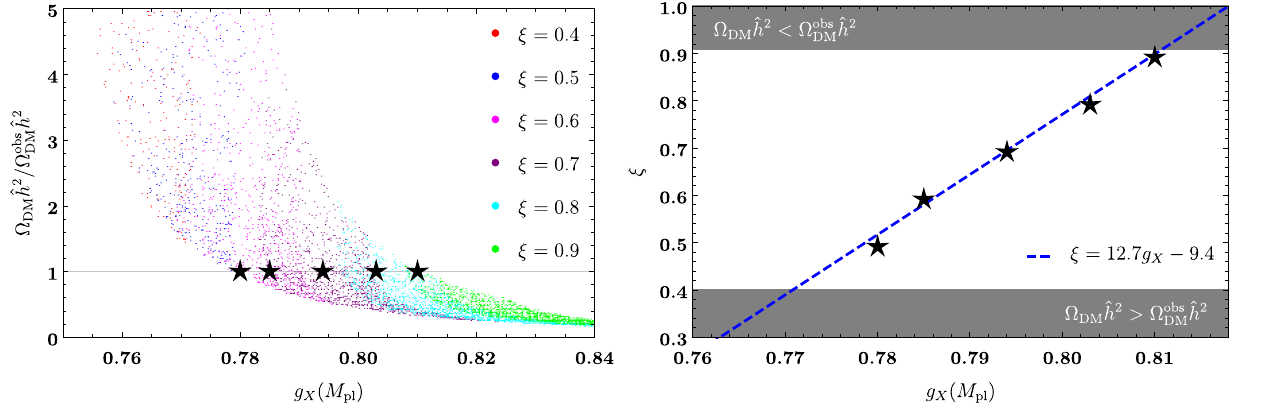
ˆ h 2 for each value of ξ . Right: ξ and g (cid:14) obs DM points. The blue dashed linear line is obtained by fitting to these points. In the gray region, (cid:14) DM ˆ h 2 /(cid:14) obs